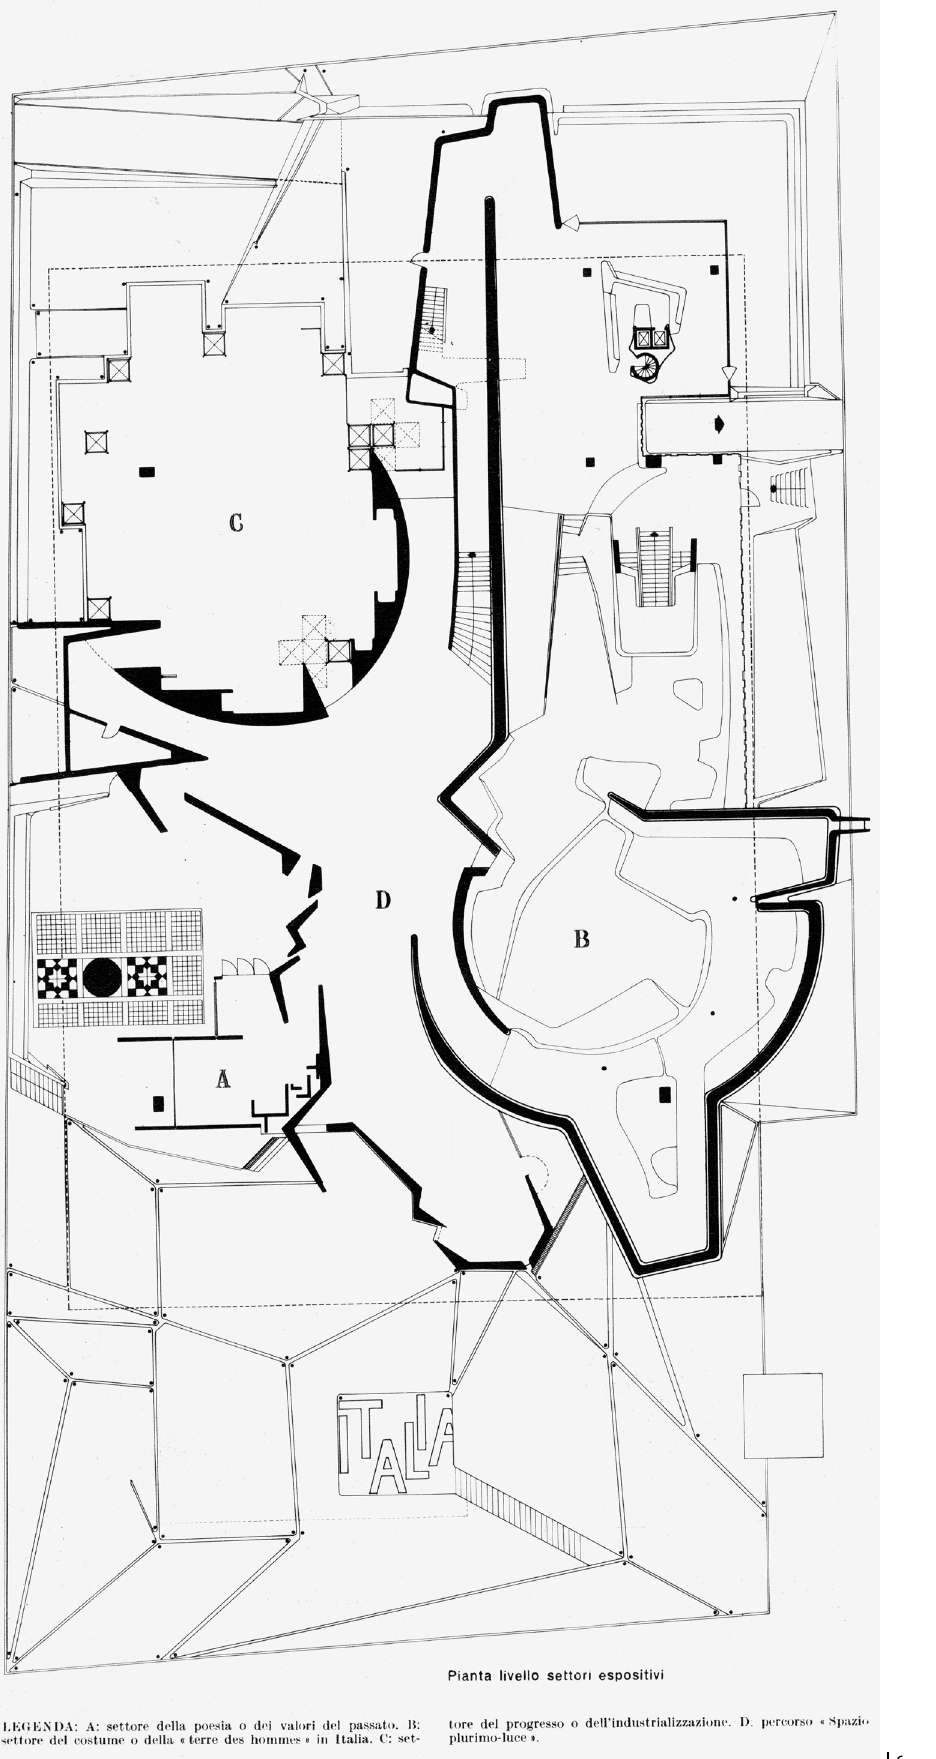
Emilio Vedova’s Percorso-Pluri- mo-Luce in the Italian pavilion,